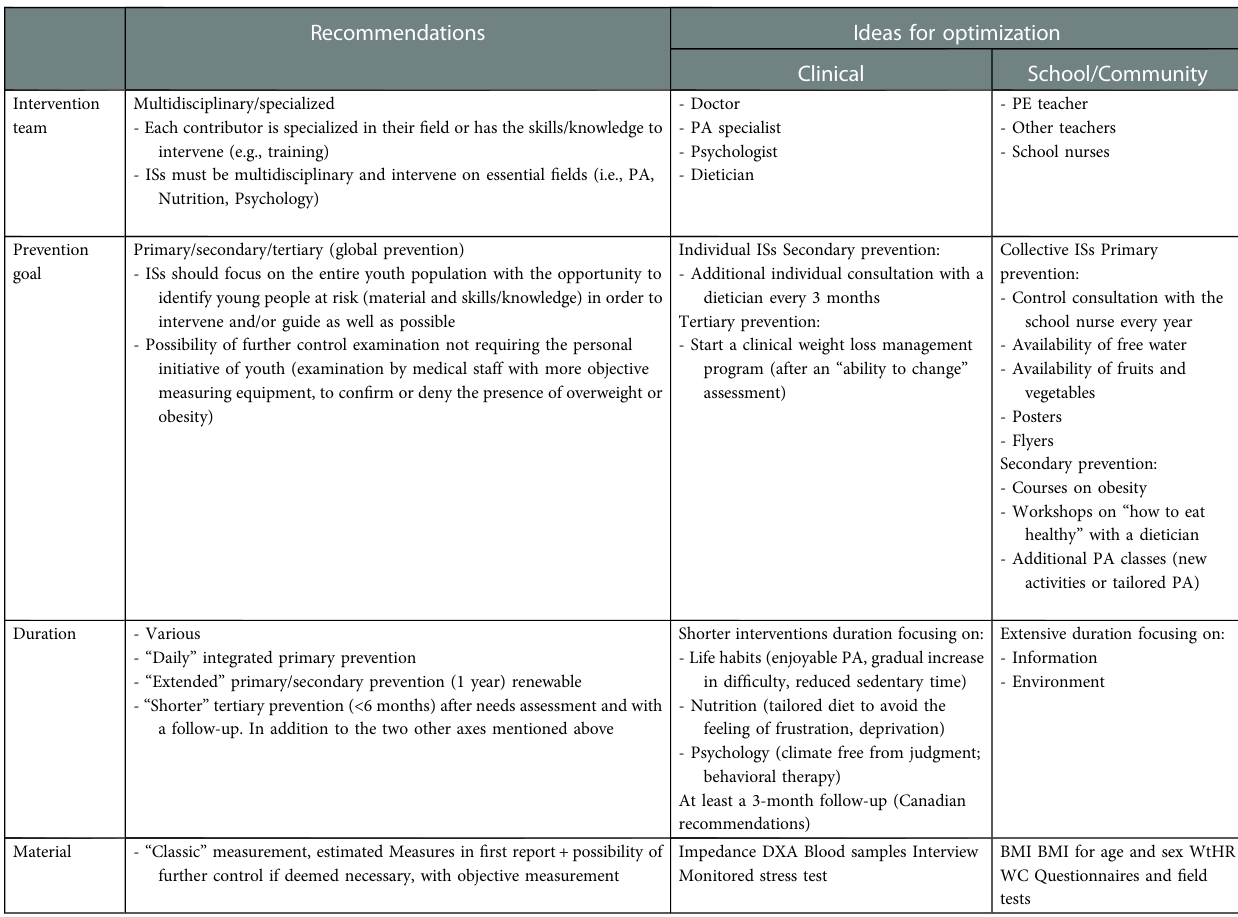
TABLE 5 Recommendations for future